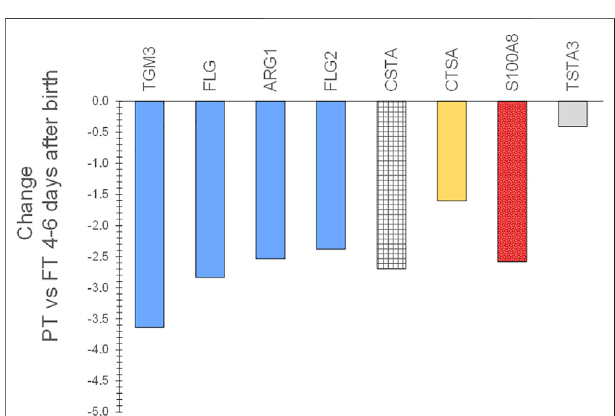
FIGURE 5 | Changes in SC proteins for PT infants compared to FT infants 4 – 8 days after birth. Two sequential skin surface samples (stratum corneum) were collected from the lower legs of 61 infants at each time and from the volar forearms of 34 adults (parent) at one time. Samples were extracted, quanti fi ed with liquid chromatography tandem mass spectrometry, and analyzed using targeted proteomics ( p < 0.05) (Visscher et al., 2020). PT infant SC had decreased expression of fi laggrin processing biomarkers FLG, FLG2,AGR1,andTGM3,antimicrobialS100A8,proteaseinhibitorCSTA,and protective protein CTSA (cathepsin A) soon after birth compared to FT infant